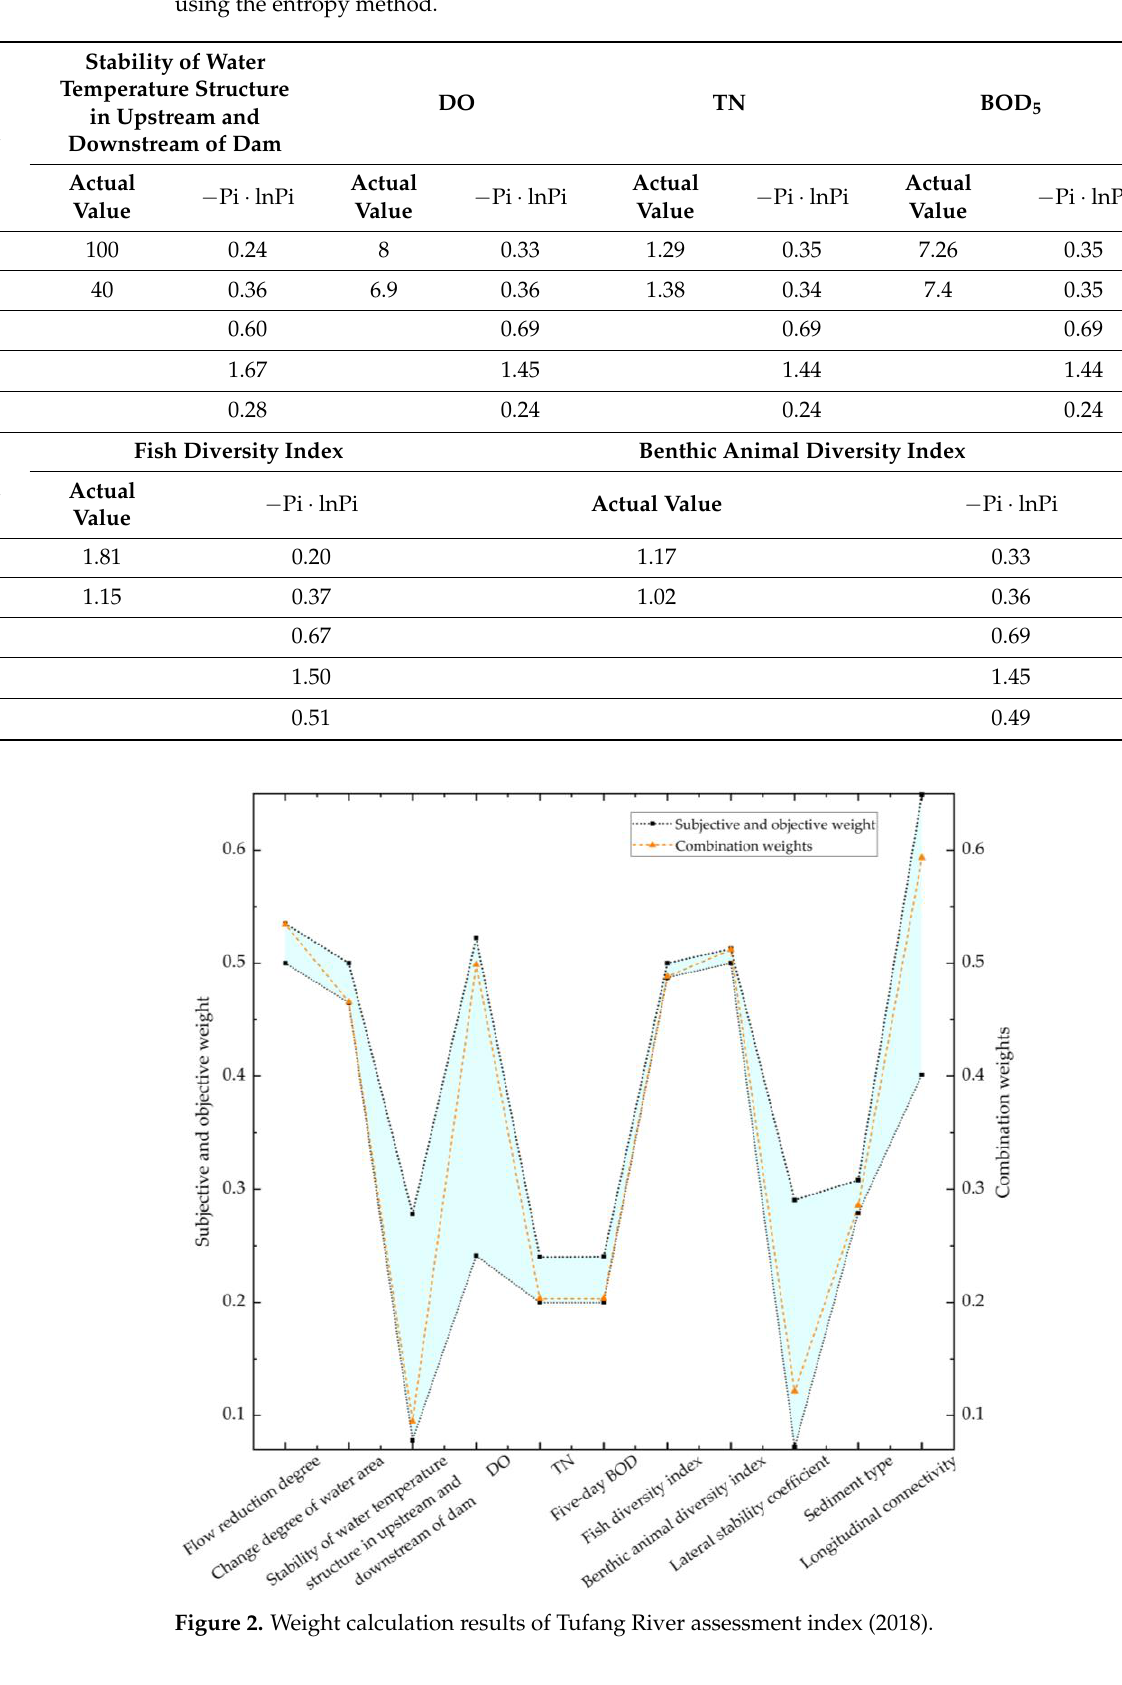
Figure 3. Weight calculation results of Tufang River assessment index (2019). 4.3. Calculation Results of Fuzzy Evaluation The membership degree of each index layer was calculated according to the trape- zoidal distribution membership function of Equations (22) – (23). Taking the river reach of